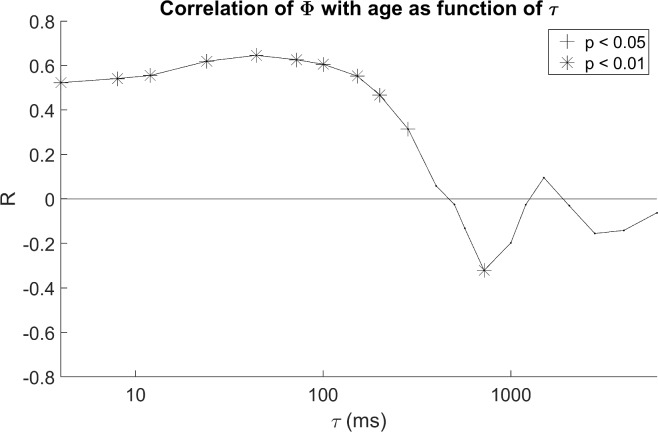
Correlation of Φ with age as a function of τ.Mean correlation coefficients of Φ with postmenstrual age for all computed values of τ. Results were pooled across groups (FNI and SC) and sleep states (AS and QS). Significant correlations are denoted by asterisks (p < 0.01) and crosses (p <0.05).